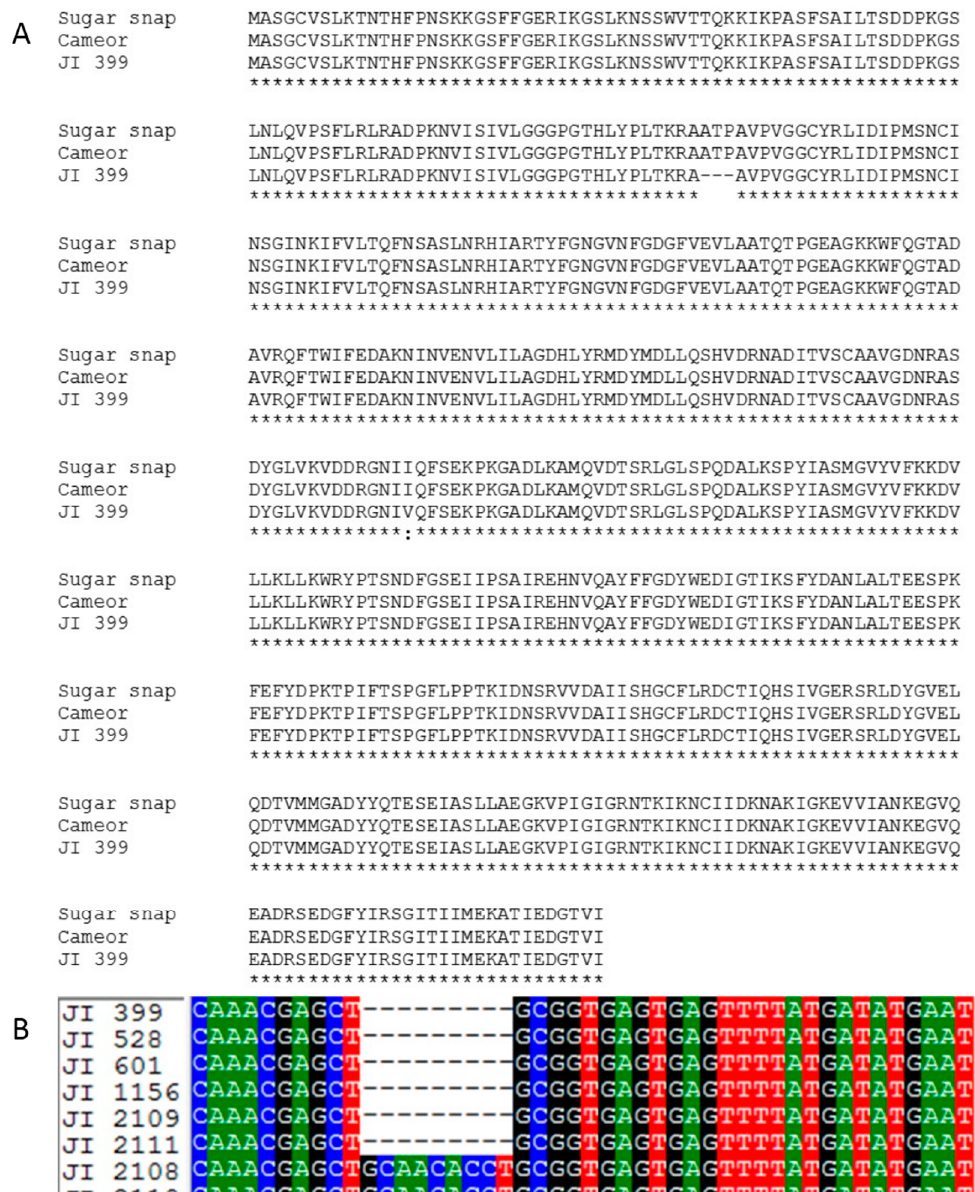
Figure 3. ( A ) Comparison of the mutant protein predicted by the agpl gene sequence in JI 399, a rb mutant lacking three amino acids (ATP) compared with the wild-type protein predicted for the cultivars Cameor and Sugar snap, the last being the source of the database NCBI submission X96766; asterisks indicate amino acid identity; ( B ) Deletion of the region in the agpl gene sequence of six germplasm accessions, all of which have a wrinkled-seeded phenotype, in comparison to the wild-type gene in two accessions. The JI accession numbers are indicated on the left of the corresponding sequences. Nucleotides are colour-coded: C, blue; A, green; G, black; T, red. (Note that intron 2 begins after the deletion, with the nucleotides GT).